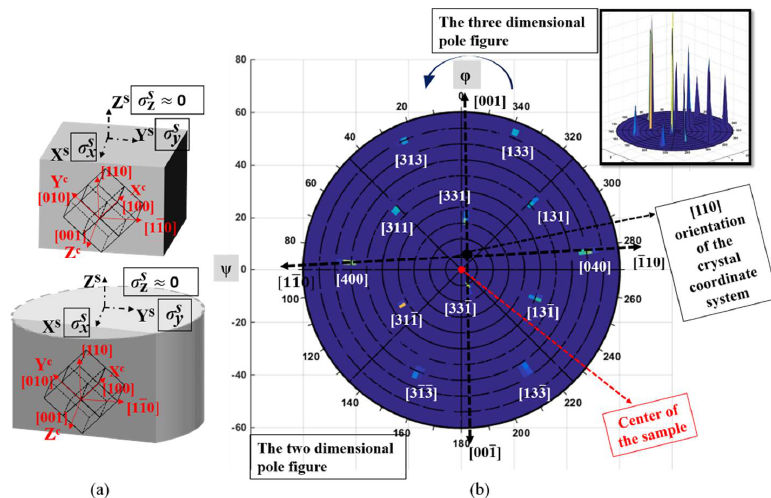
Figure 3. ( a ) Relationship between the sample surface and the crystal unit cell orientation and ( b ) the pole figure measured on the WC-C